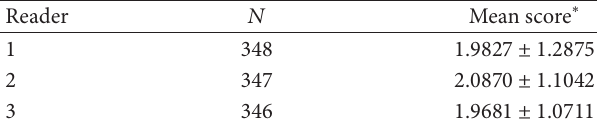
T 3: Mean visual �eld scores of the 3 readers.